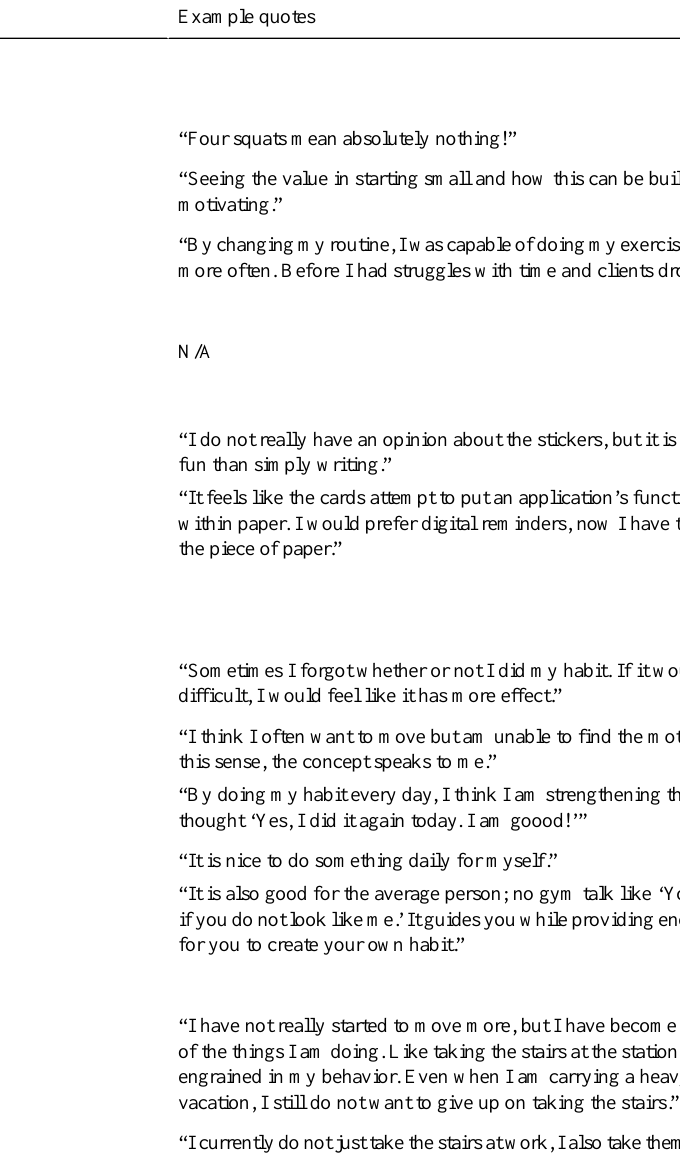
Table 1. List of core themes and relative example quotes derived from qualitative analysis of the three phases.